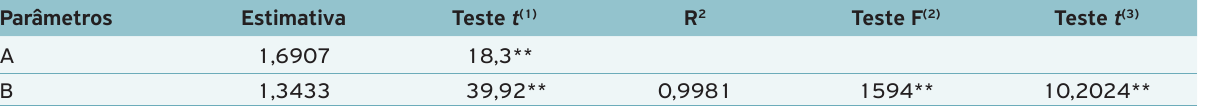
Tabela 2. Estimativas dos parâmetros da Lei de Potência de Taylor e estatísticas da análise de regressão para estudo de agregação de ataque de Heilipodus naevulus (Mannerheim, 1836). Barão de Cocais (MG), 2009.